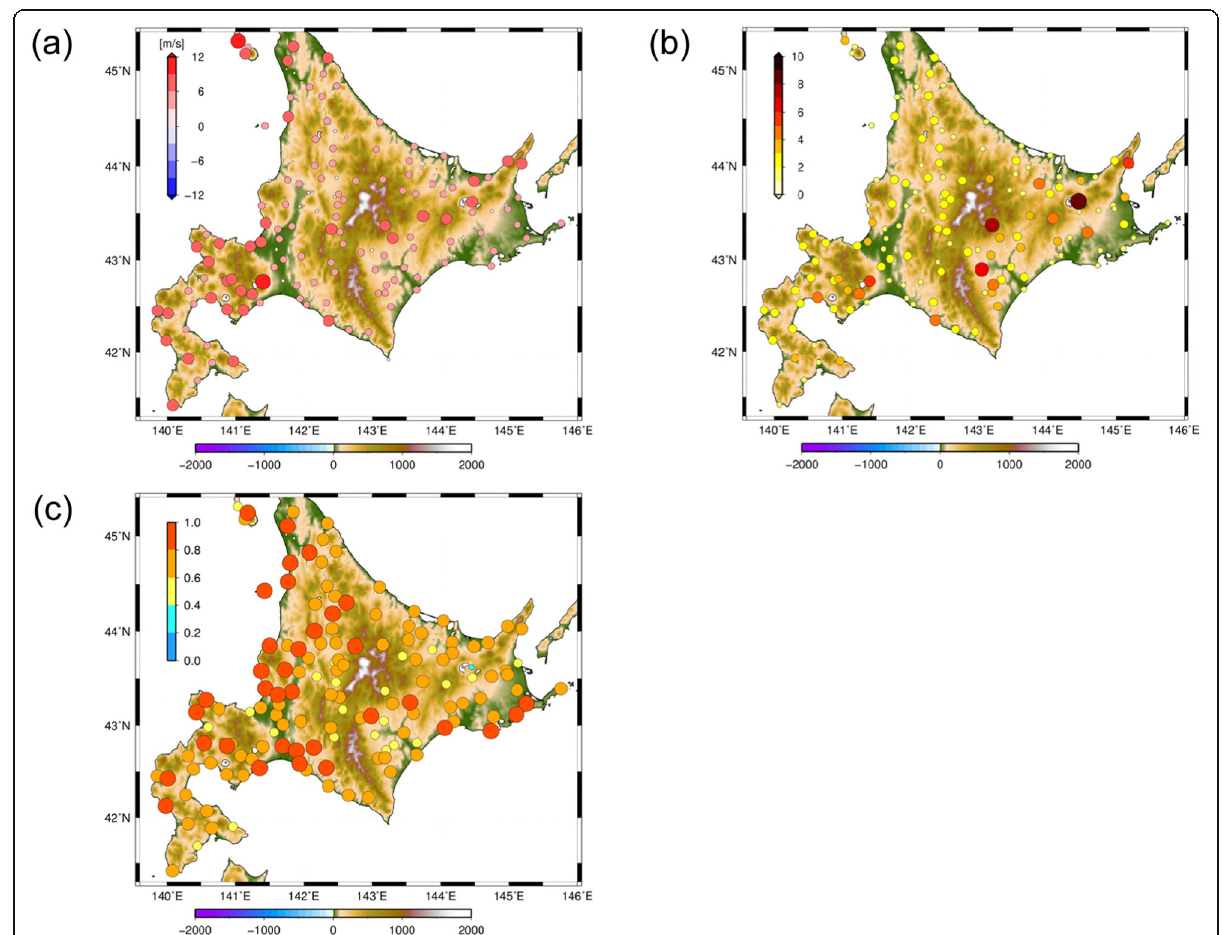
Fig. 2 Comparison of the surface winds simulated in D03 with the observations at surface stations. a The difference of the temporally averaged wind speed from the simulation to the observation. b The ratio of the variance of the simulation wind speed against that of the observation. c The Spearman ’ s rank correlation coefficient of the temporal change of wind speed between the simulation and the observation. The color shading in all the panels indicates the ground elevation